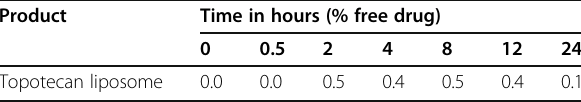
Table 13 Results of zeta potential Product